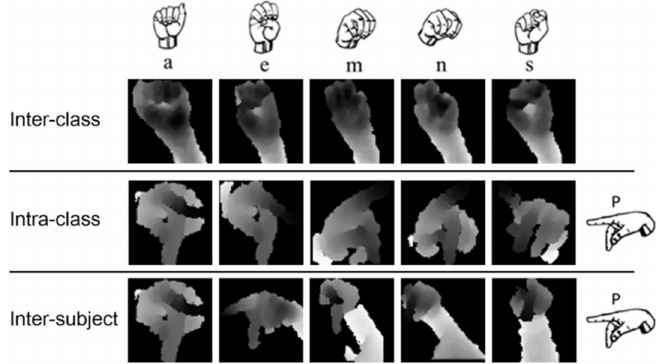
Figure 1. Inter-class similarity, intra-class variability, and inter-subject variability of hand gestures captured by a depth camera